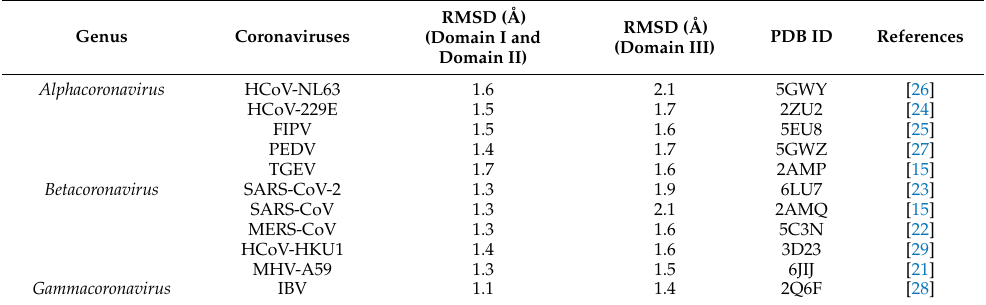
Table 2. The root-mean-square deviation (RMSD) values of domain I and domain II or domain III between the structures of PDCoV M pro and M pro s from three other CoV genera.